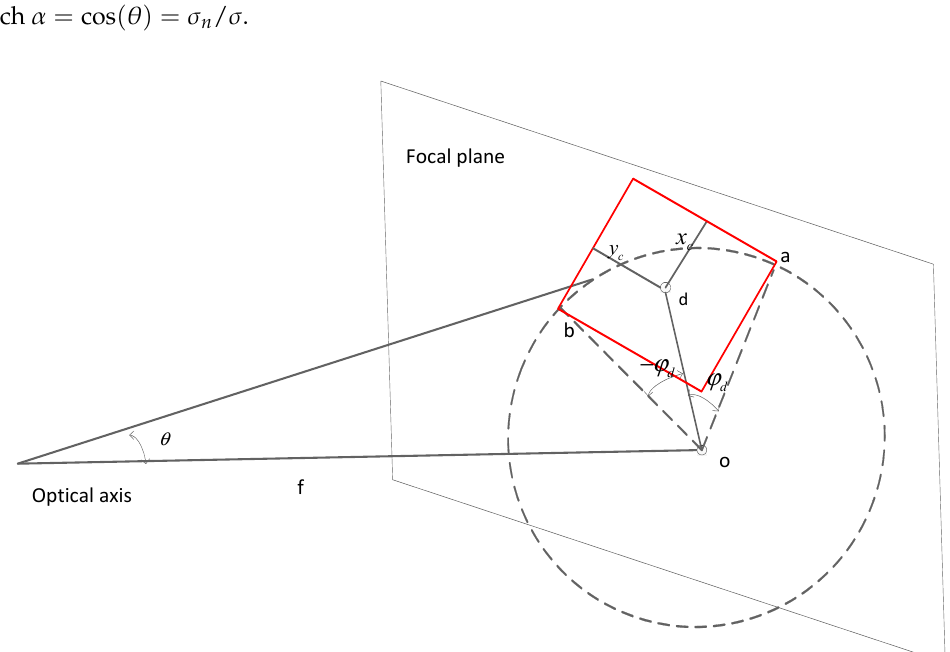
in which α = cos ( θ ) = σ n / σ .